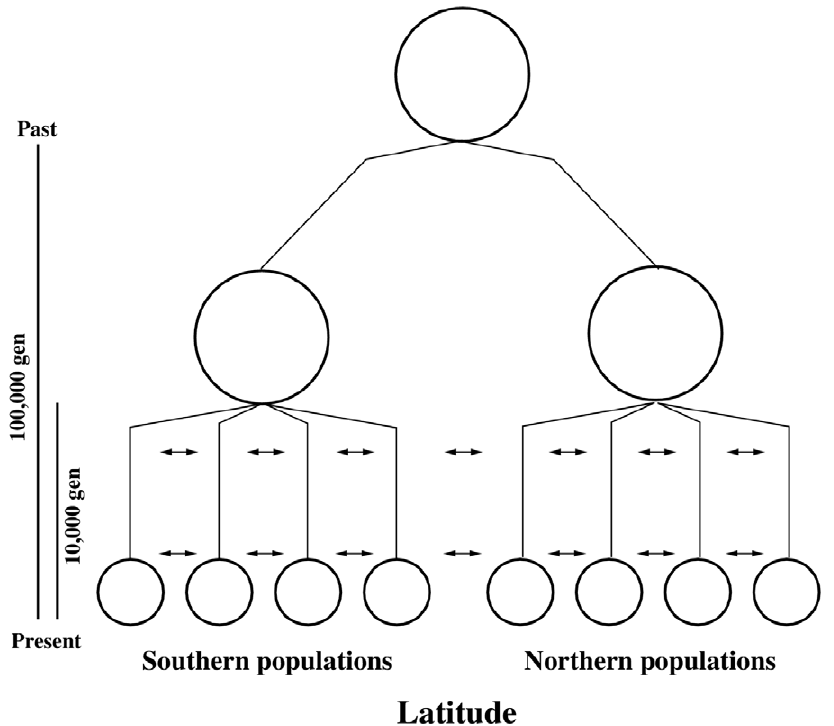
Figure 3. Demographic model for simulation study. For all simulations presented, ancestral populations are split into two relictual populations 100,000 generations in the past. At 10,000 generations before present, each of these daughter populations split into 20 linearly arranged populations (only 8 of the resulting 40 populations are indicated). Gene flow between populations continued at the same rate throughout the 10,000 generations.